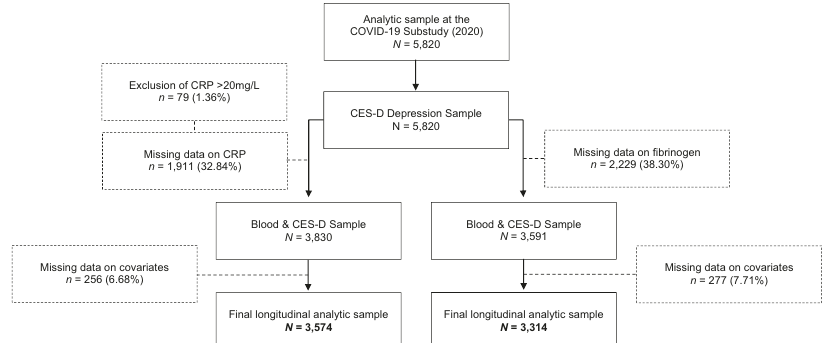
Fig. 1 Flow chart of the COVID-19 Substudy analytic sample. Data source: ELSA waves 8/9 (2016/19) and COVID-19 Substudy